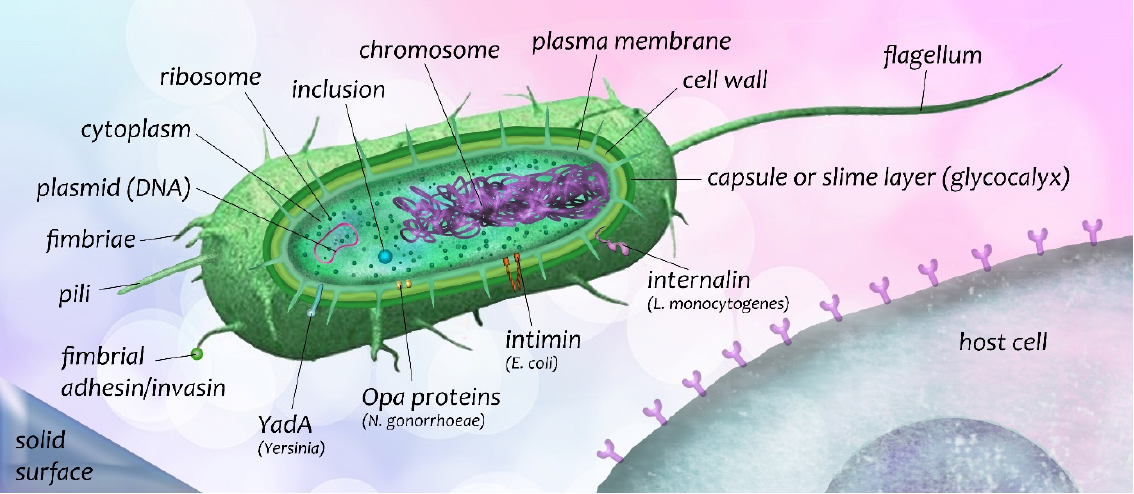
Figure 3. Schematic illustration of bacterial cell structure. The main types of adhesive molecules are also illustrated. Adhesins mediate attachment of pathogenic bacteria to host cells. Adhesive molecules that also promote the internalization are called invasins. However, not all the bacterial species have all the illustrated adhesive molecules. For example, enteropathogenic Yersinia has YadA, that helps to adhere to epithelial cells. N. meningitidis and N. gonorrhoeae express a number of Opas and also Opcs, highly variable opacity-associated outer membrane proteins. E. coli strains (enteropathogenic and enterohemorrhagic) produce the outer membrane protein intimin that recognizes minimum two types of receptors on the surface eukaryotic cell. L. monocytogenes synthetizes various homologous surface proteins, termed internalins, which are significant for bacterial entry into eukaryotic cells. Furthermore, bacteria can adhere to a plant, animal, or another bacterial cell by juxtaposing its own glycocalyx to the surface of the desired cell. Bacterial adhesion to an inert, solid surface must overcome the evolving electrostatic repulsive forces.